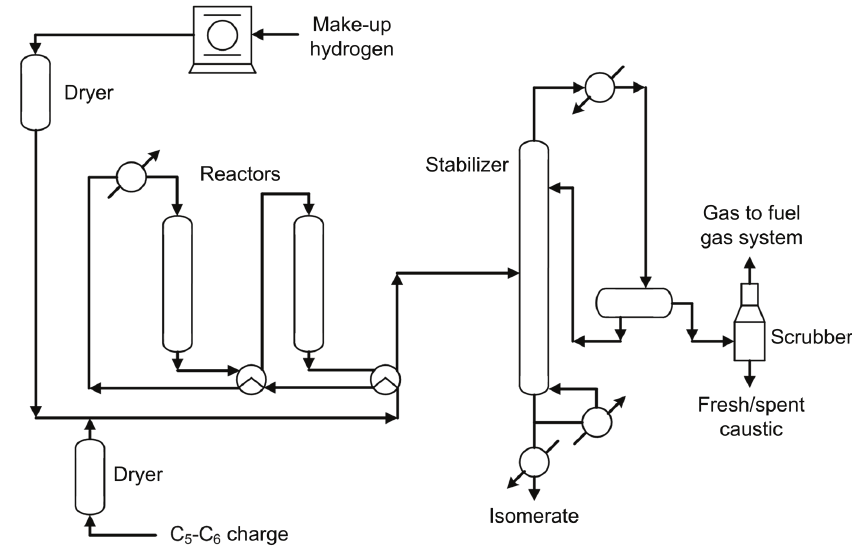
Fig. 3 – Straight-through isomerisation process